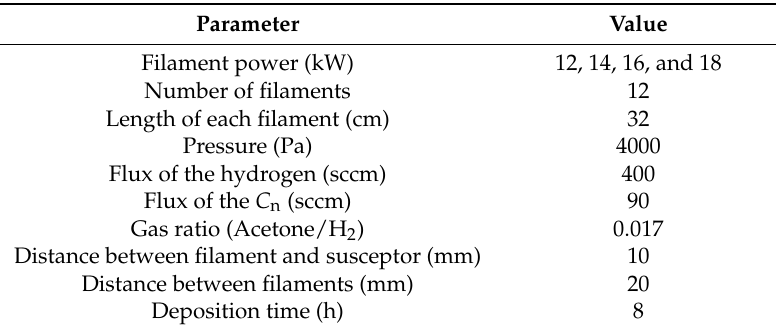
Table 1. Detail of experimental conditions.